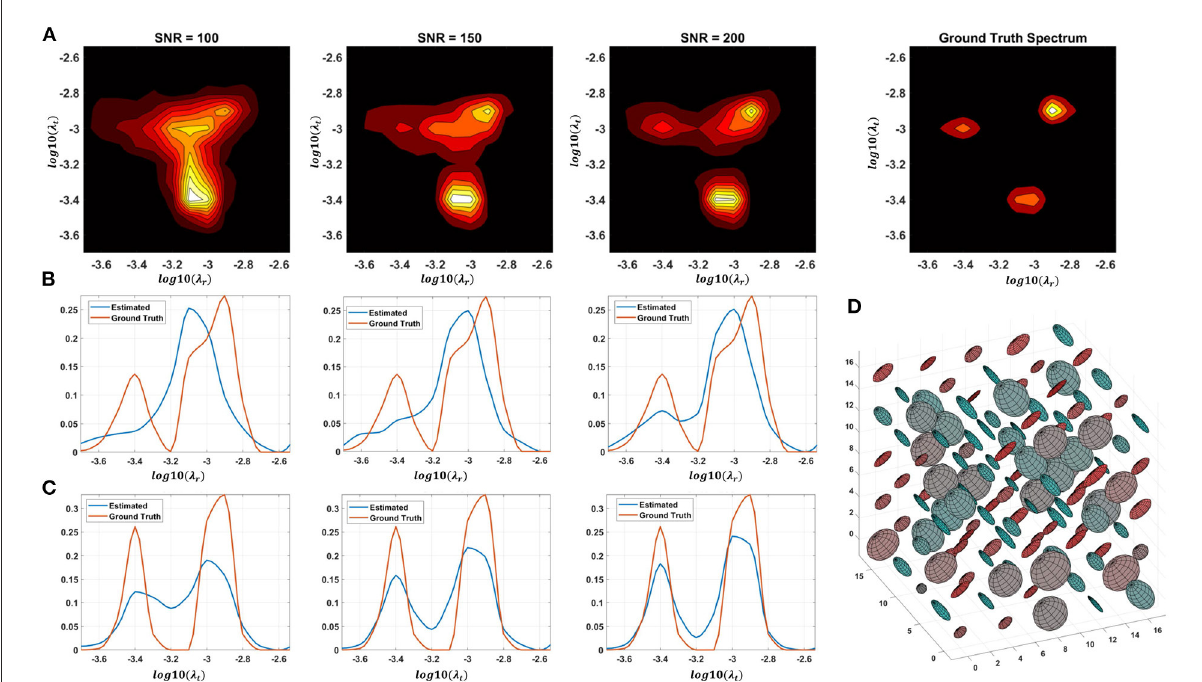
FIGURE4 Monte-Carlo simulation results illustrating the accuracy and numerical stability of the 2D cDTD reconstruction as a function of SNR. (A) : Log-log plots of mean normalized 2D cDTD correlation spectra of principal diffusivities reconstructed at different SNR levels. (B,C) : Log plots of mean normalized 1D marginal distributions derived from the 2D cDTDs in the top row. (D) : A numerically simulated illustration of an ensemble of diffusion tensors described by the ground truth 2D